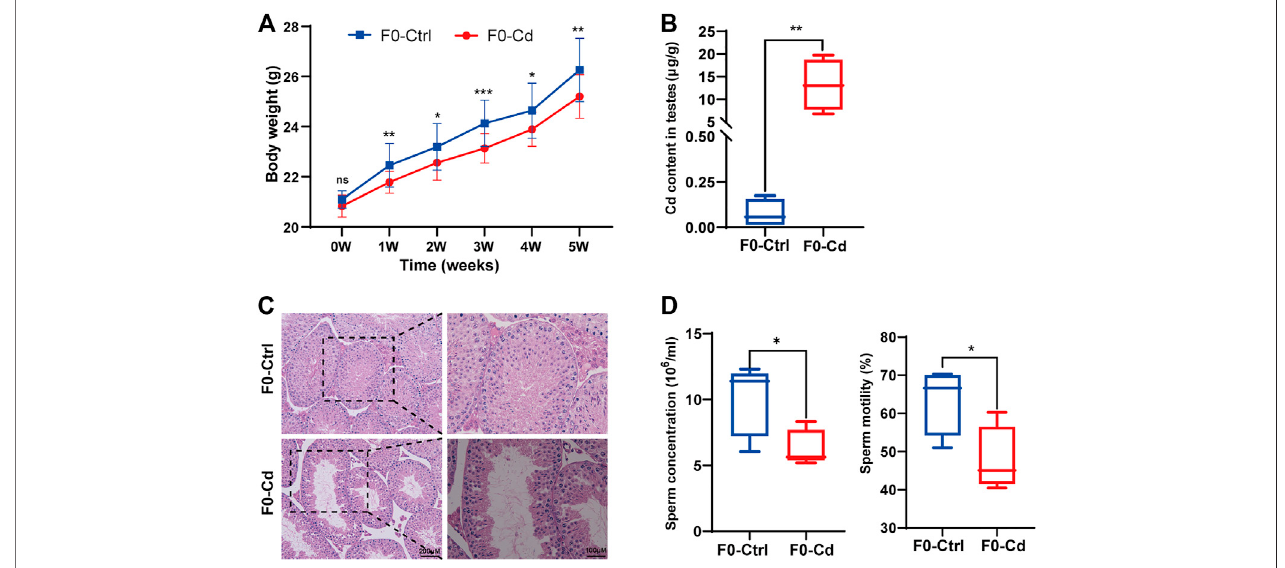
FIGURE1| EffectsofCdexposureonmalereproductivesysteminmice. (A) BodyweightofF0males( n (cid:1) 15). (B) CdcontentinthetestesofF0mice( n (cid:1) 5). (C) HE results of the testis in F0 mice. (D) Sperm concentration and sperm motility in F0 mice ( n (cid:1) 5). All results are expressed as the mean ± SD. Labeled asterisk represents statistical signi fi cance compared with the respective control group. * p < 0.05, ** p < 0.01 and *** p < 0.001. ns, no signi fi cant difference.